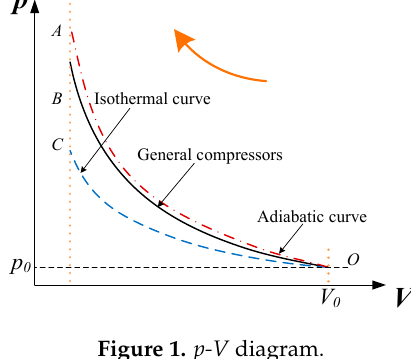
Figure 1. p-V diagram.